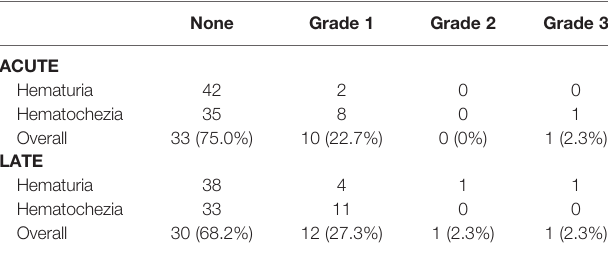
TABLE 2 | Cumulative incidence of acute and late CTC-graded hematuria and